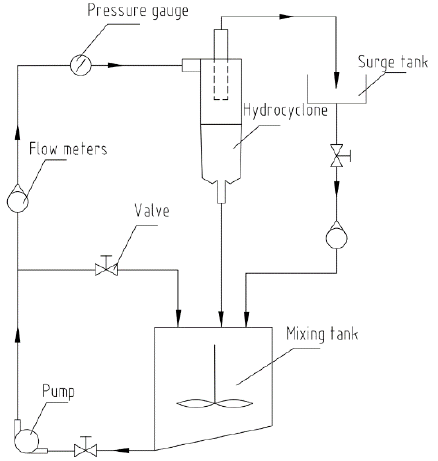
Figure 5. Hydrocyclone separation performance test set-up.